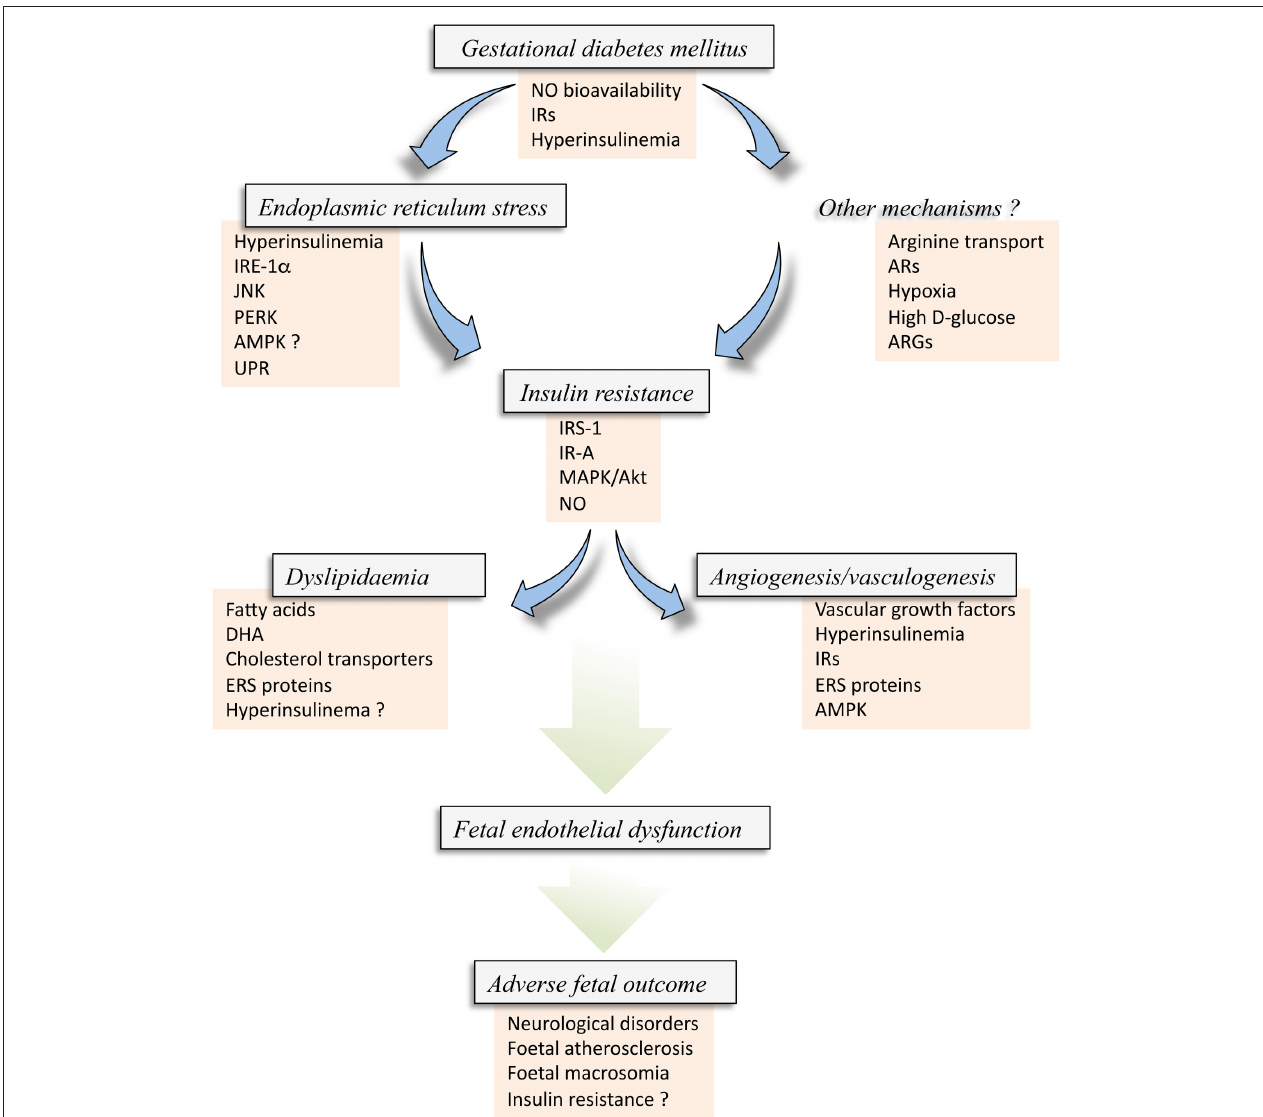
FIGURE 4 | Insulin resistance in the fetus from gestational diabetes mellitus. Gestational diabetes mellitus (GDM) is a disease coursing with fetal hyperinsulinemia and associated with metabolic alterations that result in reduced bioavailability of nitric oxide (NO) and altered expression of insulin receptors (IRs). These alterations, and perhaps hyperinsulinemia itself, may result in abnormal expression and activity of several molecules associated with endoplasmic reticulum stress (ERS) [IRE-1 α , JNK, PERK, and likely AMPK (AMPK?)], which could also lead to the activation of the unfolded protein response (UPR) pathway. ERS via this set of alterations could result in Insulin resistance in the fetus/newborn. Insulin resistance could alternatively be caused by Other mechanisms , including membrane transport of L-arginine, the substrate for NO synthesis, adenosine receptors (ARs) expression and/or activation, hypoxia or high extracellular concentration of D-glucose, and arginases (ARGs) activity, a metabolic pathway that consume L-arginine in endothelial cells. All these factors could result in increased inhibitor phosphorylation of IRS-1, perhaps involving the subtype A of IRs (IR-A) with a deficient signaling pathway mediated by p44/42 mapk (MAPK) and protein kinase B/Akt. These phenomena lead to reduced synthesis and/or bioavailability of NO in the endothelial cells from the human placenta. Since insulin signaling is crucial maintaining a normal metabolism of lipids and angiogenesis and vasculogenesis in the human placenta from normal pregnancies, GDM-associated fetal insulin resistance could result in altered mother- to -fetus transplacental transfer due to altered expression and activity of cholesterol transporters, and metabolism of lipids leading to accumulation of fatty acids, docosahexaenoic acid (DHA), or cholesterol. A generalized metabolic disturbance referred as Dyslipidaemia . The latter is also associated with increased expression of ERS markers, and could also be due to hyperinsulinemia (Hyperinsulinemia ?). Additionally, insulin resistance results in a lack of modulation of physiological Angiogenesis and vasculogenesis in pregnancy where and increase in vascular growth factors, hyperinsulinemia, IRs and ERS molecules, including AMPK activity, are potentially involved. All these phenomena, i.e., GDM, ERS, angiogenesis and dyslipidaemia, develop with altered expression and activity of common molecules due to the state of insulin resistance in the fetoplacental vasculature. The final result is an abnormal function of the fetal endothelium ( Fetal endothelial dysfunction ) that ends with Adverse fetal outcome characterized by increased risk of fetal/newborn atherosclerosis, macrosomia, neurological disorders, and insulin resistance.